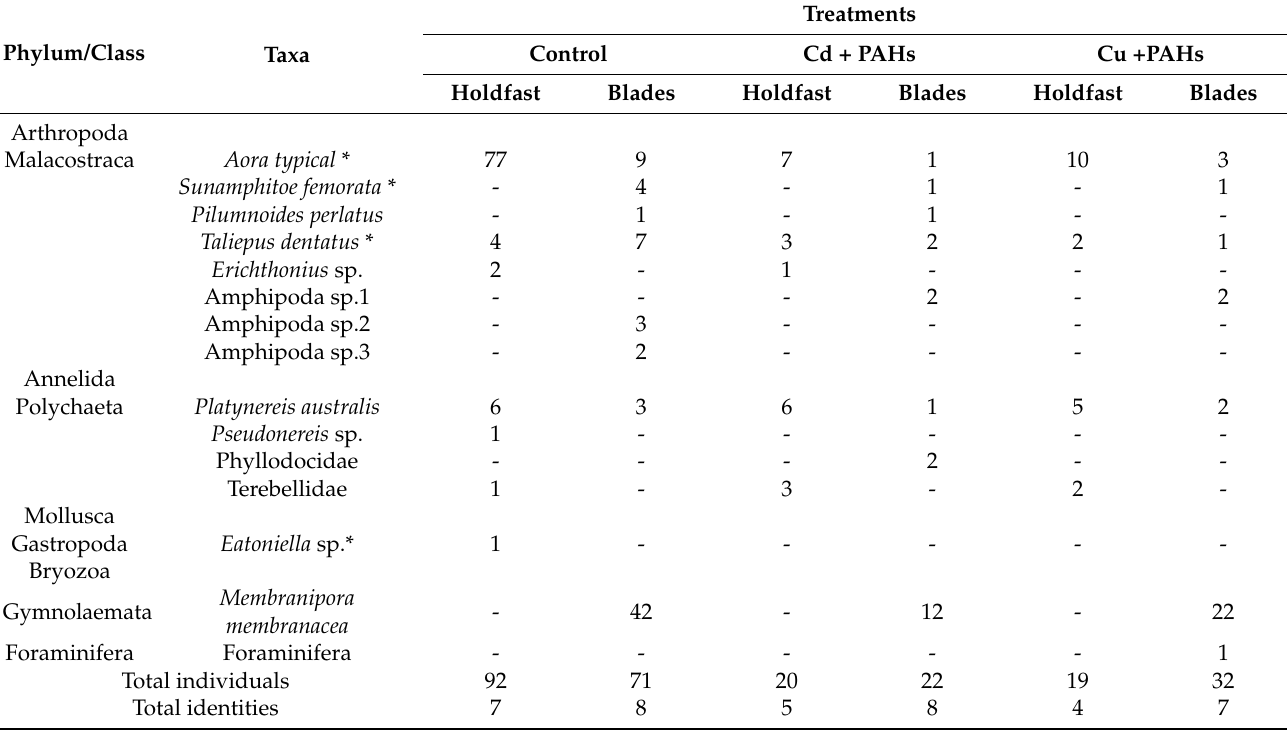
Table 1. Macroinvertebrates found in the holdfast and blades of Macrocystis pyrifera and their respective abundances, for algae exposed to a mixture of contaminants and the control group (without toxic exposure). * Indicate species that feed on M. pyrifera